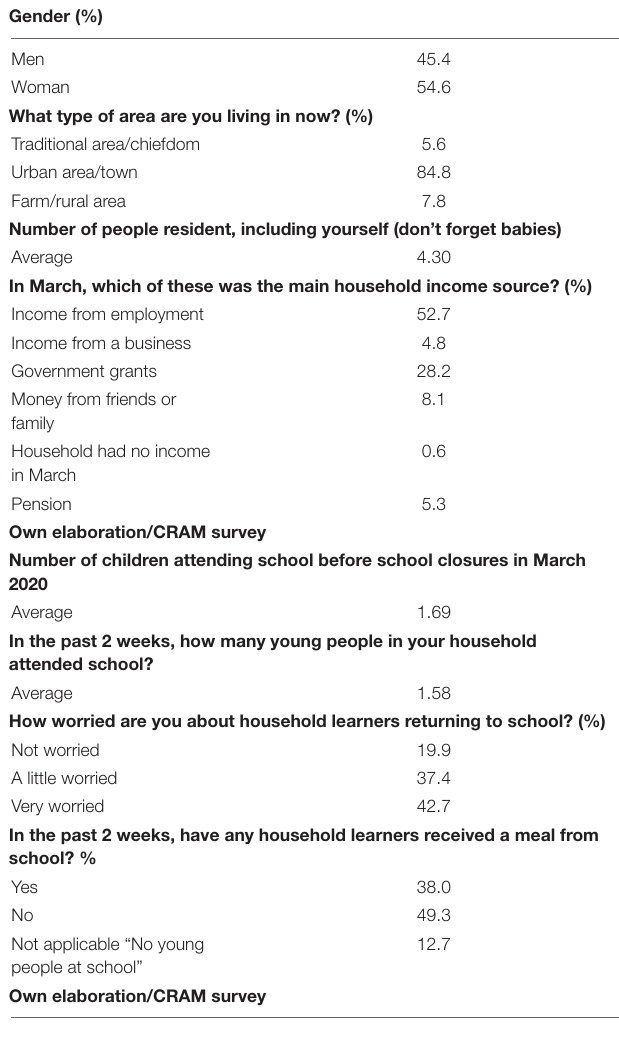
TABLE 1 | Descriptive approach to the situation in Gauteng in May